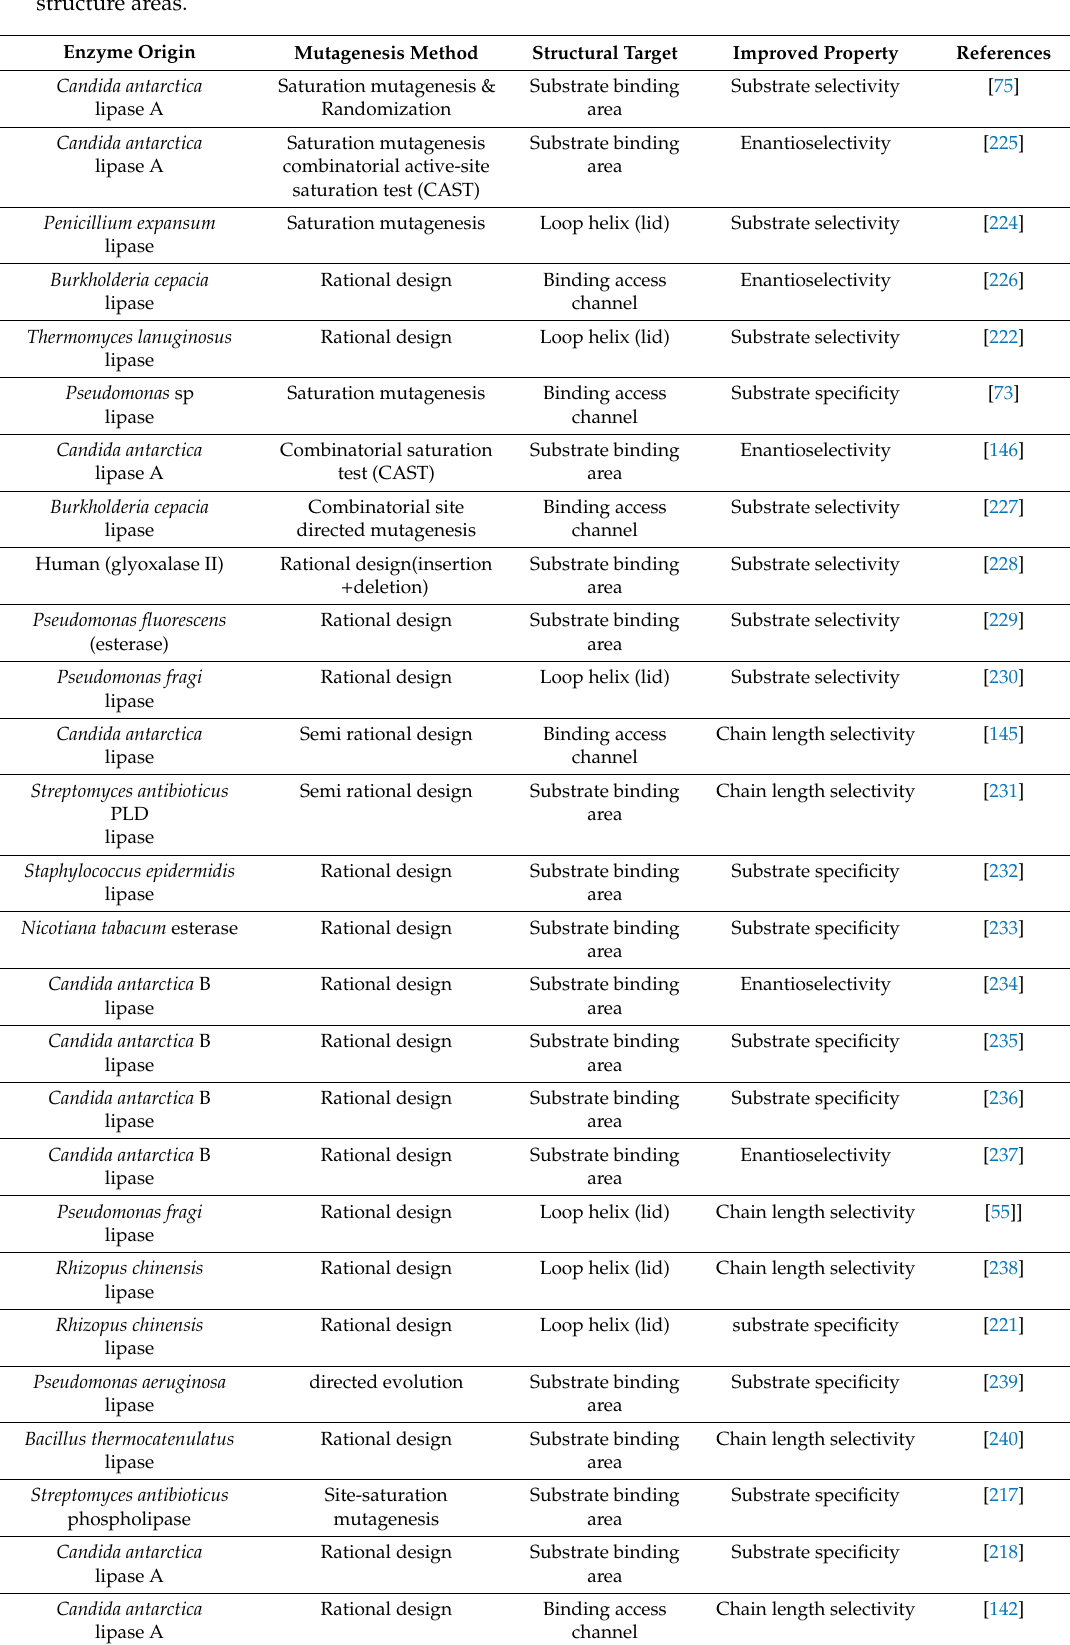
Table 3. Selected examples of lipases with improved protein specificity by targeting di ff erent structure